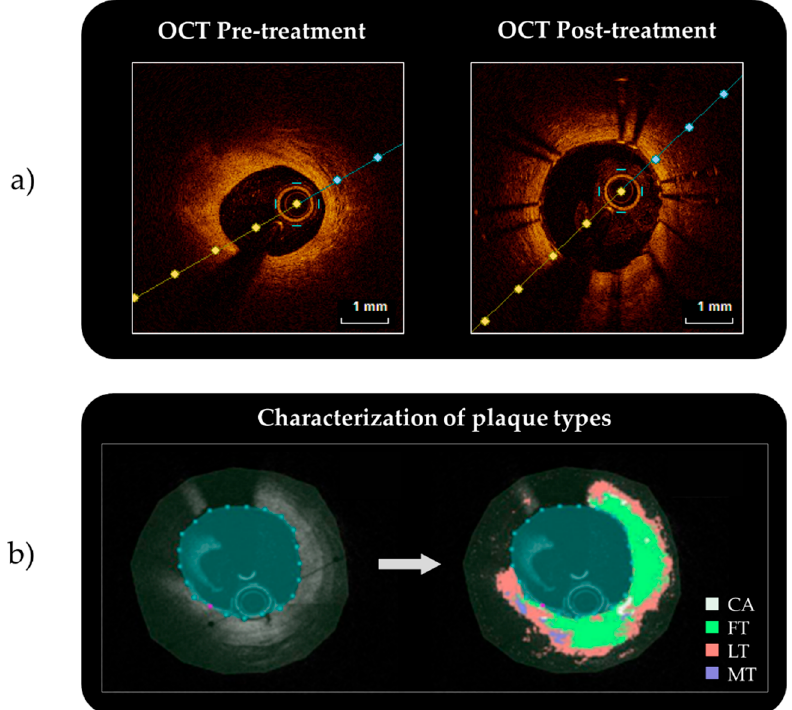
Figure 1. OCT images were used for the reconstruction of the patient-specific artery and plaque: ( a ) good OCT image quality was required both for the reconstruction of the artery from the OCT pre-treatment images and for the quantitative comparison of the OCT post-treatment lumen areas and model results; ( b ) a CNN was used to characterize the plaque types (calcified plaque (CA), fibrous tissue (FT), lipid tissue (LT), mixed tissue (MT)) from patient OCT images.